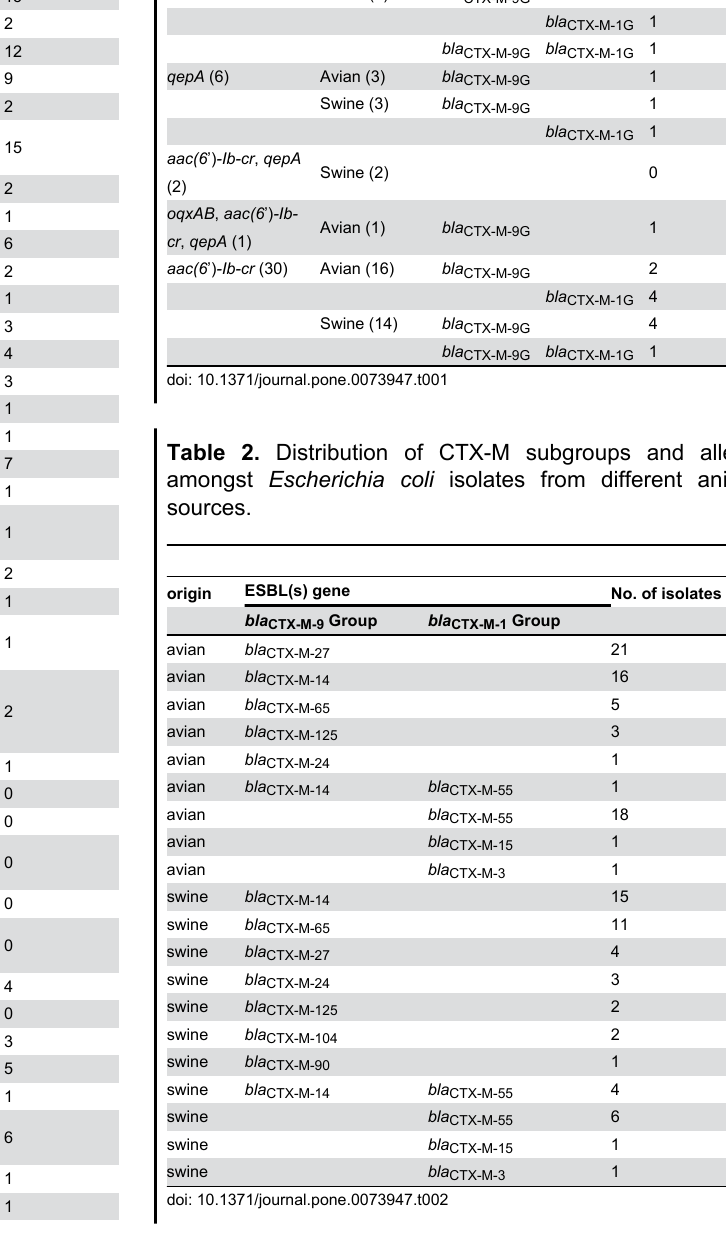
very small plasmid not detected using S1-PFGE). As listed in Table 3, the IncFII (5 different alleles) replicon types were detected in 13 transconjugants, 7 of them carrying two